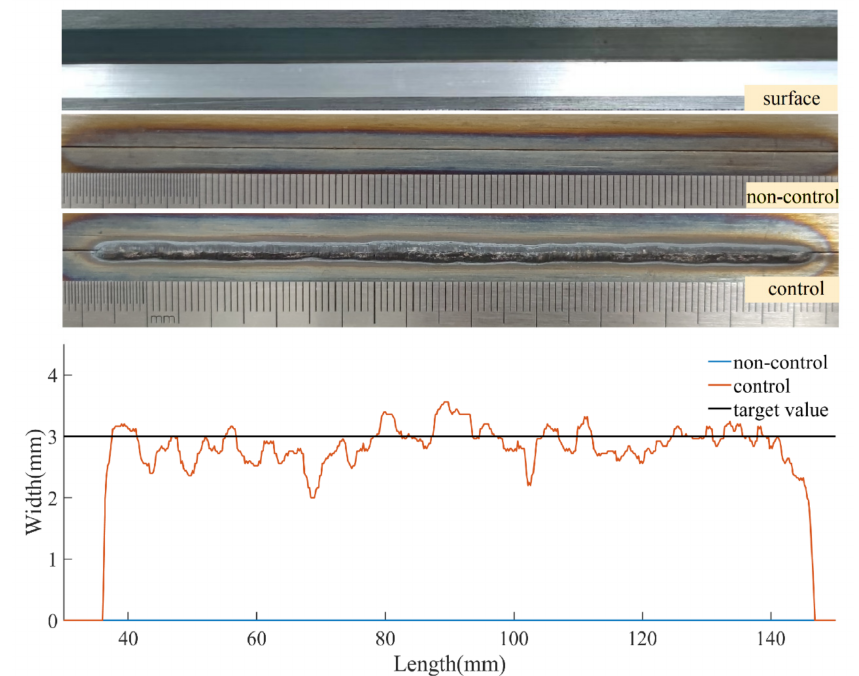
Figure 7. Comparison of results of the bottom molten pool width of butt welding with a groove angle of 30 ◦ .